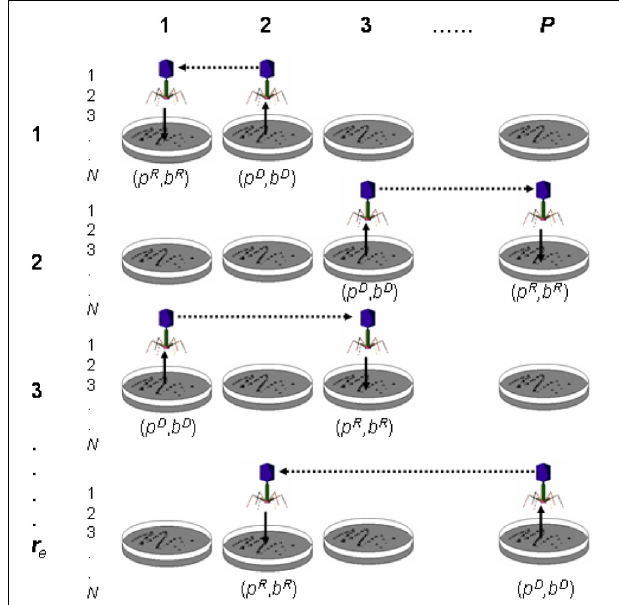
FIGURE 9 | Transduction experiment. The figure shows transduction from donor Petri dish ( p D ) and bacterium ( b D ) to recipient Petri dish ( p R ) and bacterium ( b R ). In the figure, P is the total number of Petri dishes (or sub-populations), N is the number of bacteria (or population size) per Petri dish and r e the number of experimental